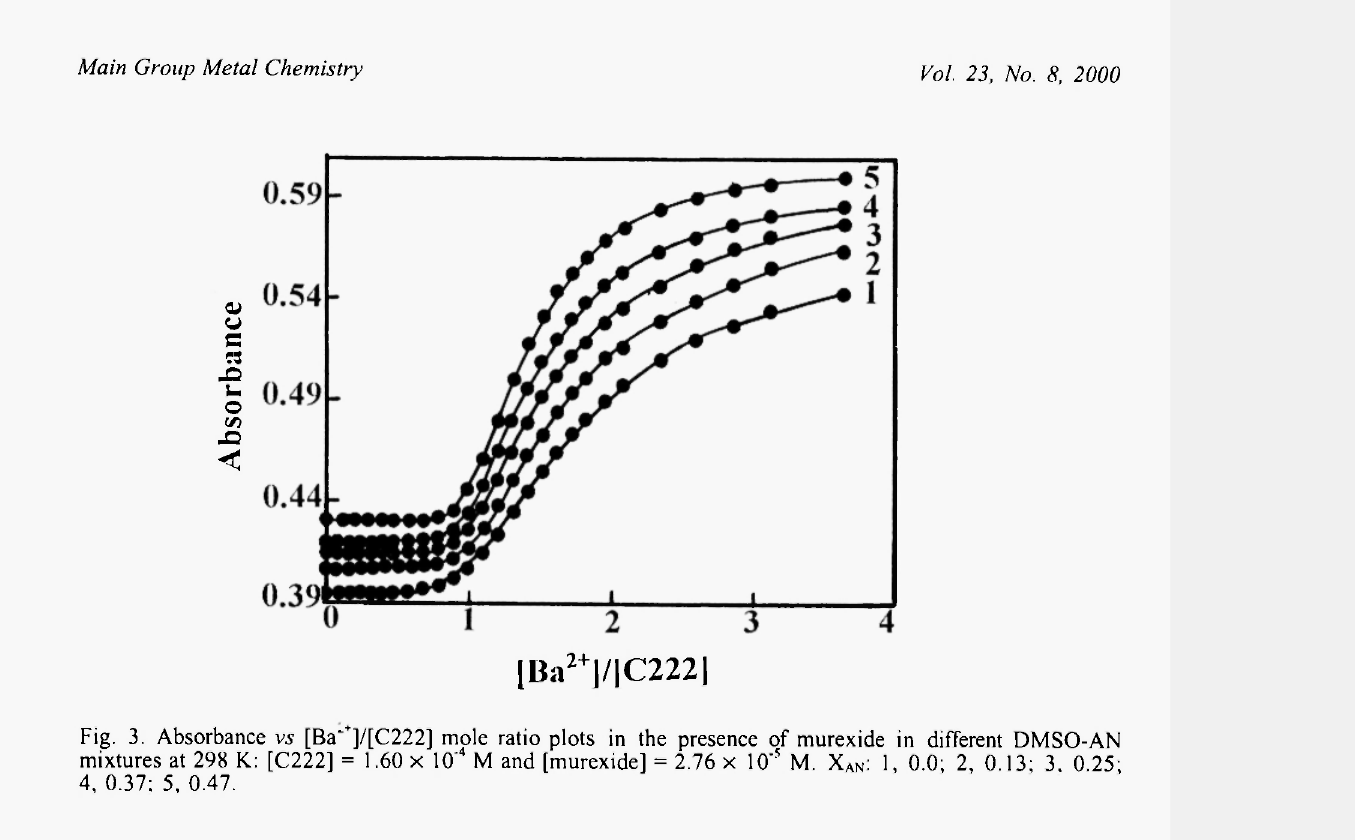
Fig. 3. Absorbance vs [Ba*"]/[C222] mole ratio plots in the presence of murexide in different DMSO-AN mixtures at 298 K: [C222] = 1.60 χ ΙΟ" 4 Μ and [murexide] = 2.76 χ ΙΟ" 5 Μ. X AN : 1, 0.0; 2, 0.13; 3, 0 25; 4, 0.37; 5, 0.47.